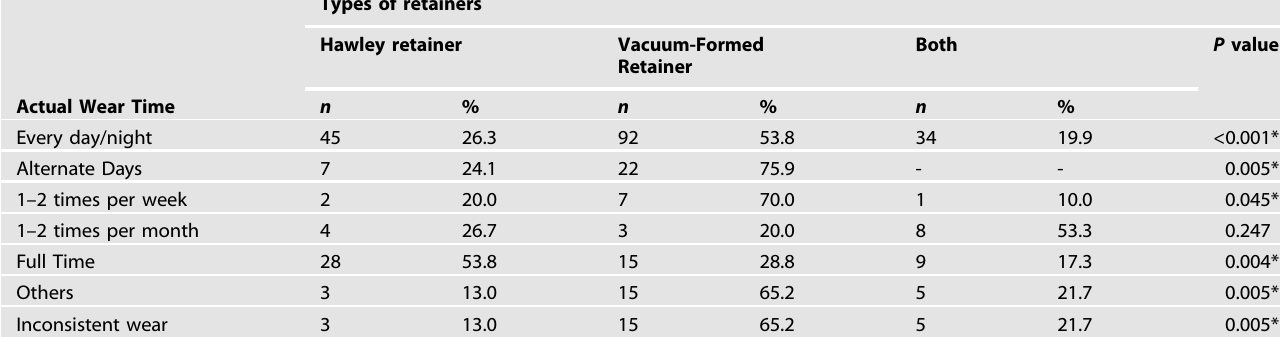
Table 4. Actual wear time according to type of retainers.